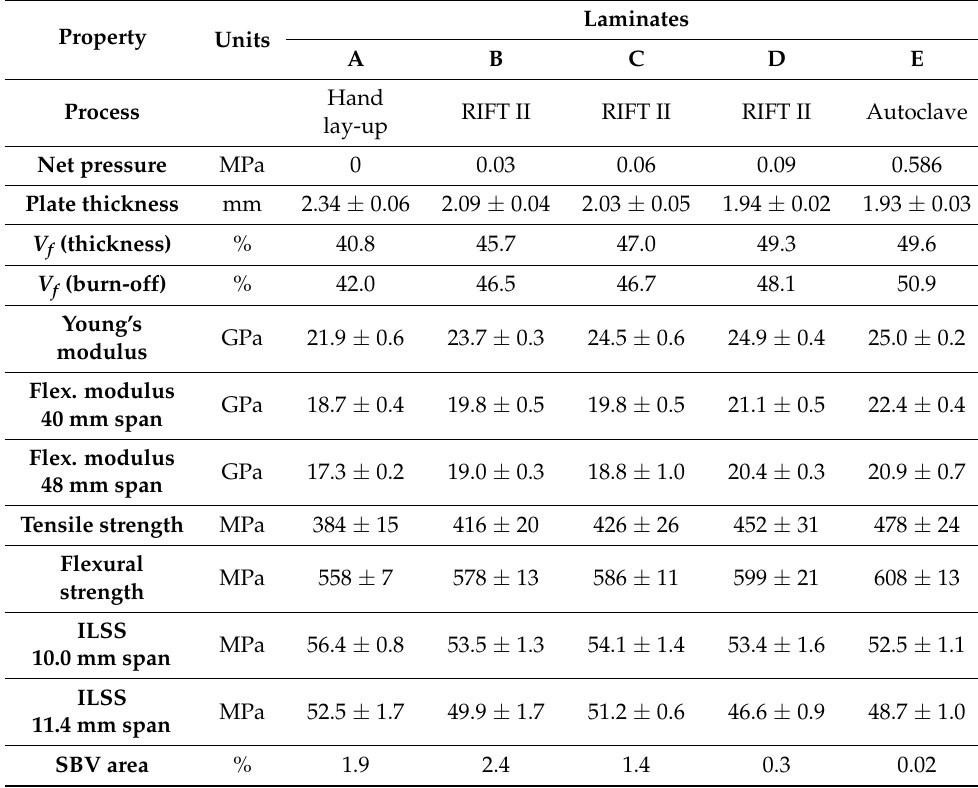
Table 2. Results from each laminate characterization tests [31]. Property